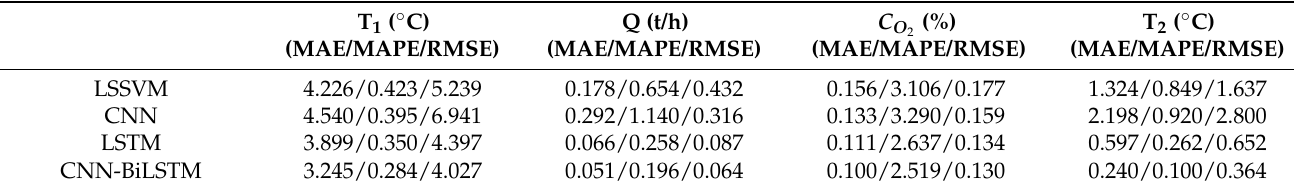
Table 4. Influence of different models on modeling